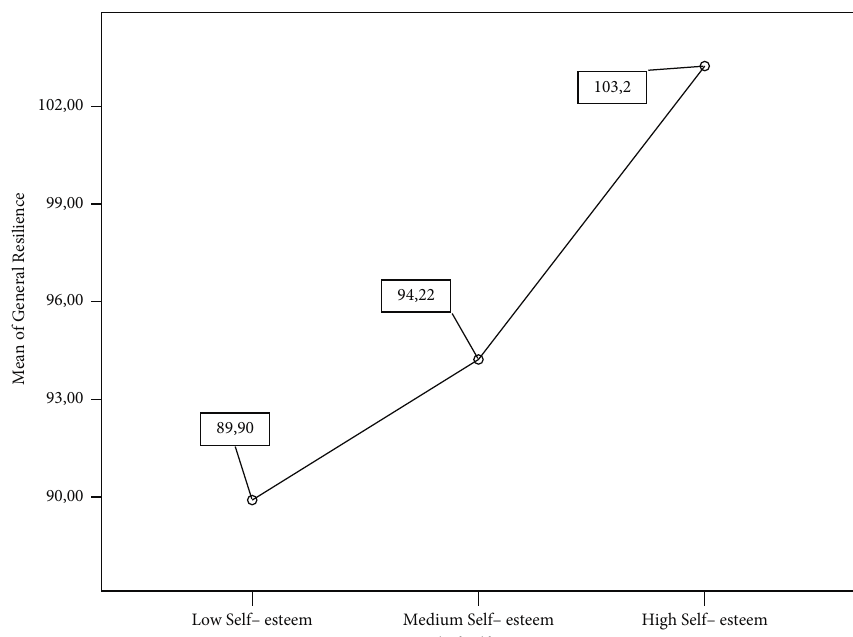
Figure 3: Differences in resilience according to self-esteem levels.